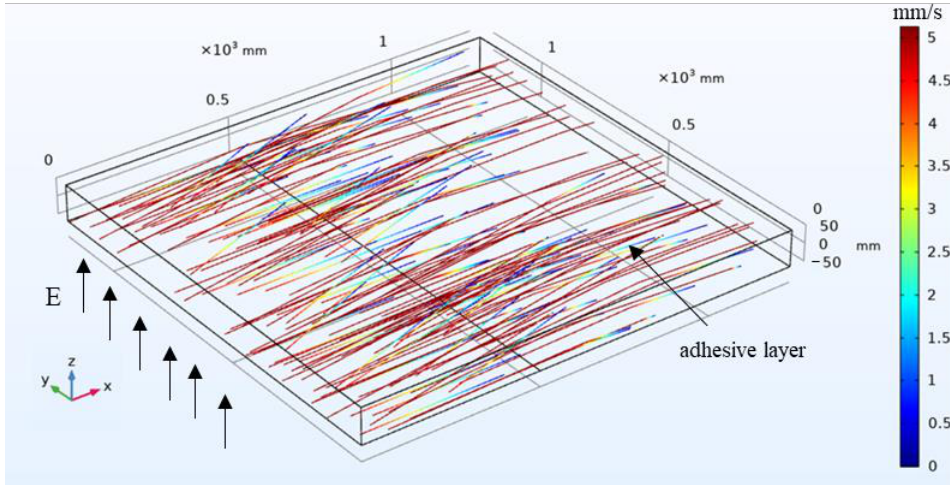
Figure 8. Particle motion of the field model.